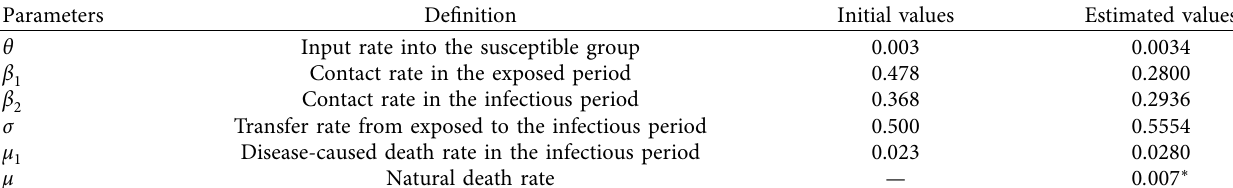
Table 2: The estimated values of model parameters by least-squares method.